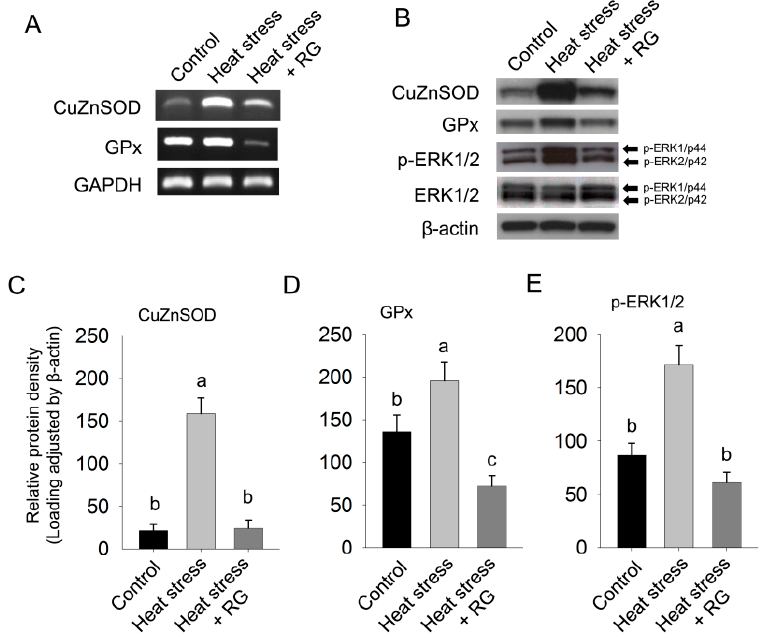
Figure 7. Oxidative stress related gene expression in the control, heat stress, and heat stress with orally administered Red ginseng extracts (RG) groups. ( A ) The protein level of CuZnSOD, GPx, and GAPDH was determined by semi-quantitative RT-PCR; ( B ) The protein level of CuZnSOD, GPx, p-ERK, ERK and β -actin was determined by western blotting; ( C ) The protein expression of CuZnSOD was normalized by β -actin; ( D ) The protein expression of GPx was normalized by β -actin; ( E ) The protein expression of p-ERK was normalized by β -actin. The results are expressed as means ± standard deviation ( n = 8). Values with different letters are significantly different, p < 0.05.